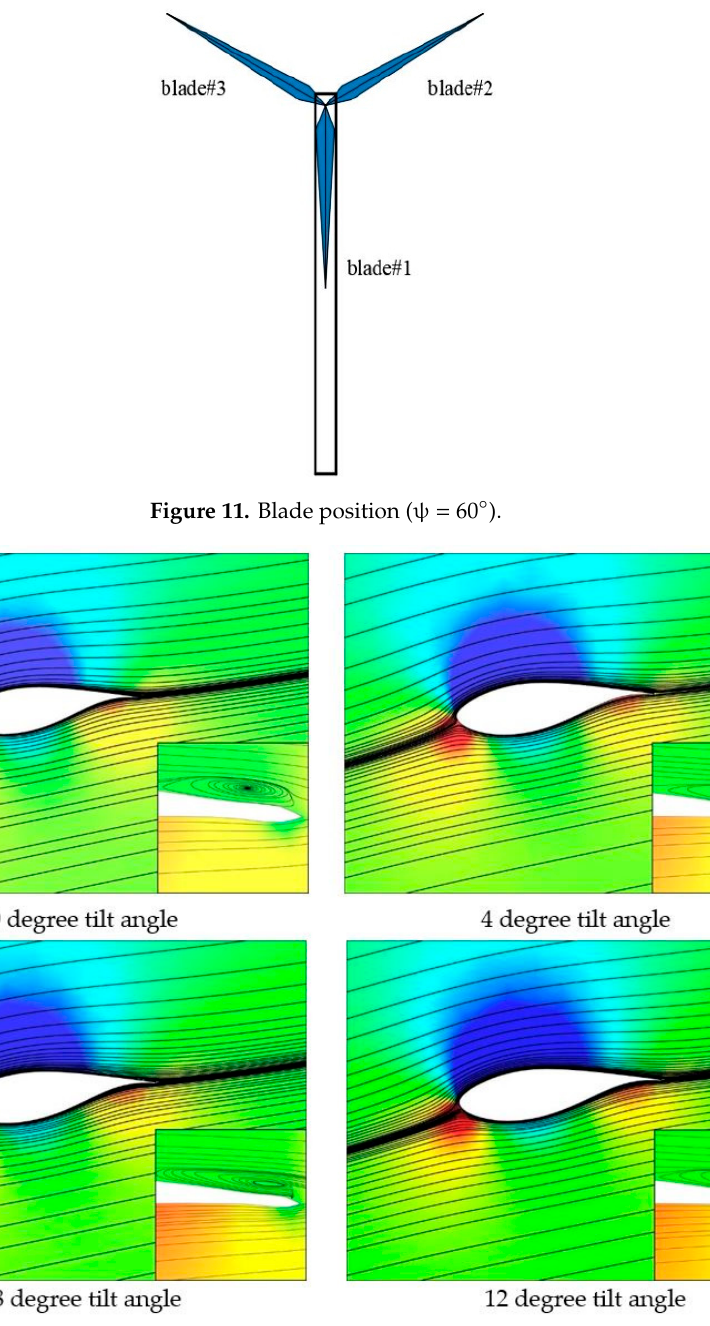
Figure 12. Instantaneous pressure magnitude and streamlines diagram (r/R = 0.5).